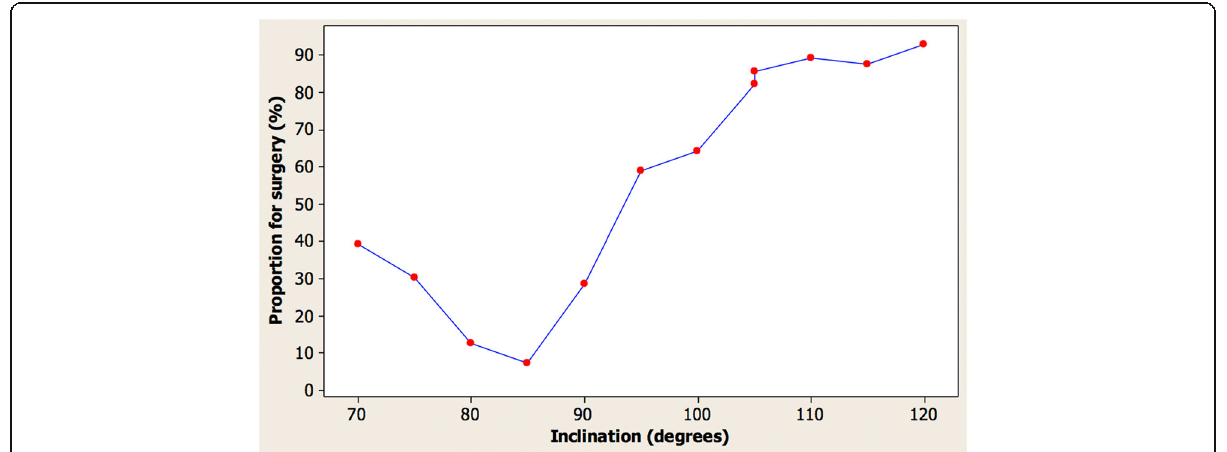
Fig. 7 Proportion of laypeople suggesting a desire for treatment vs. inclination in female images